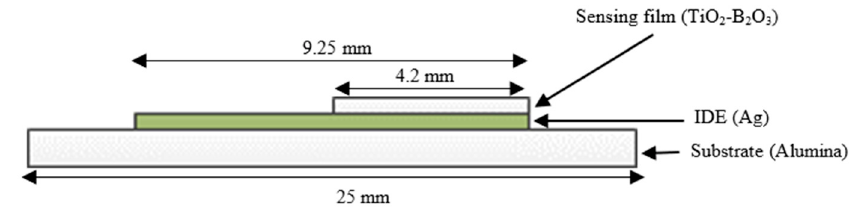
Figure 1. Front view of the TiO 2 -B 2 O 3 gas sensor.